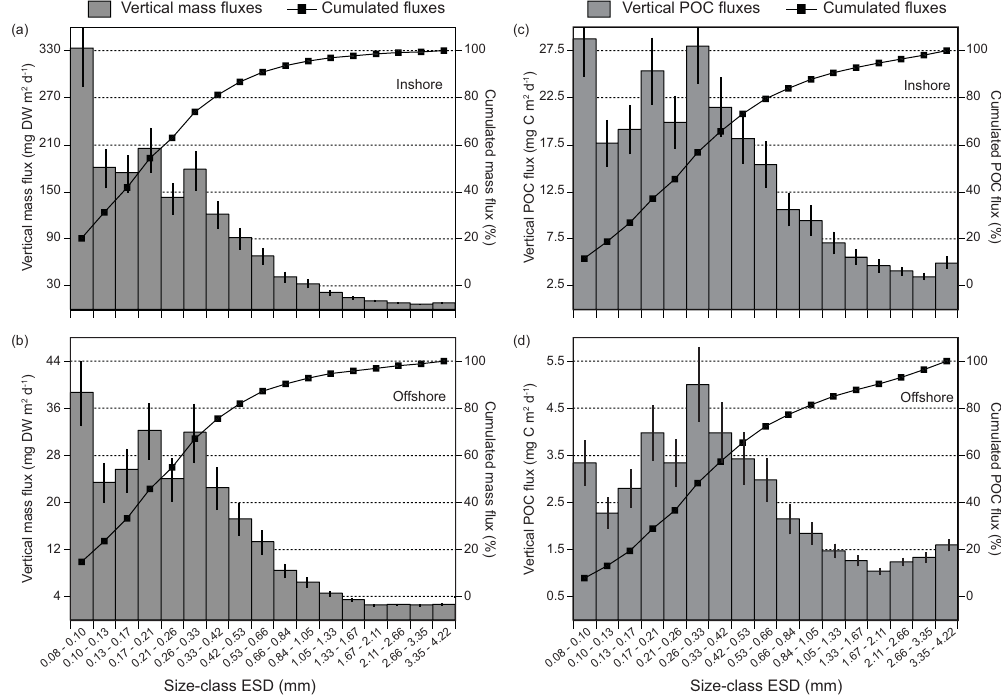
Fig. 10. Histograms of average vertical mass fluxes (a, b) and vertical POC fluxes (c, d) within each size class considered to estimate the fluxes using the empirical equations and the UVP5 dataset. The relative cumulated flux for each size distribution is also presented in each panel. Absolute cumulated fluxes (total of all size classes) in the inshore and offshore zone were (a, b) 1646 and 263mgDW,m − 2 d − 1 for the mass fluxes, respectively, whereas they were (c, d) 244 and 43mgCm − 2 d − 1 for the POC fluxes, respectively. The inshore and offshore regions are delimited by the 100m isobath, which corresponds to the shelf break. Vertical bars depict the standard error associated with each vertical flux size